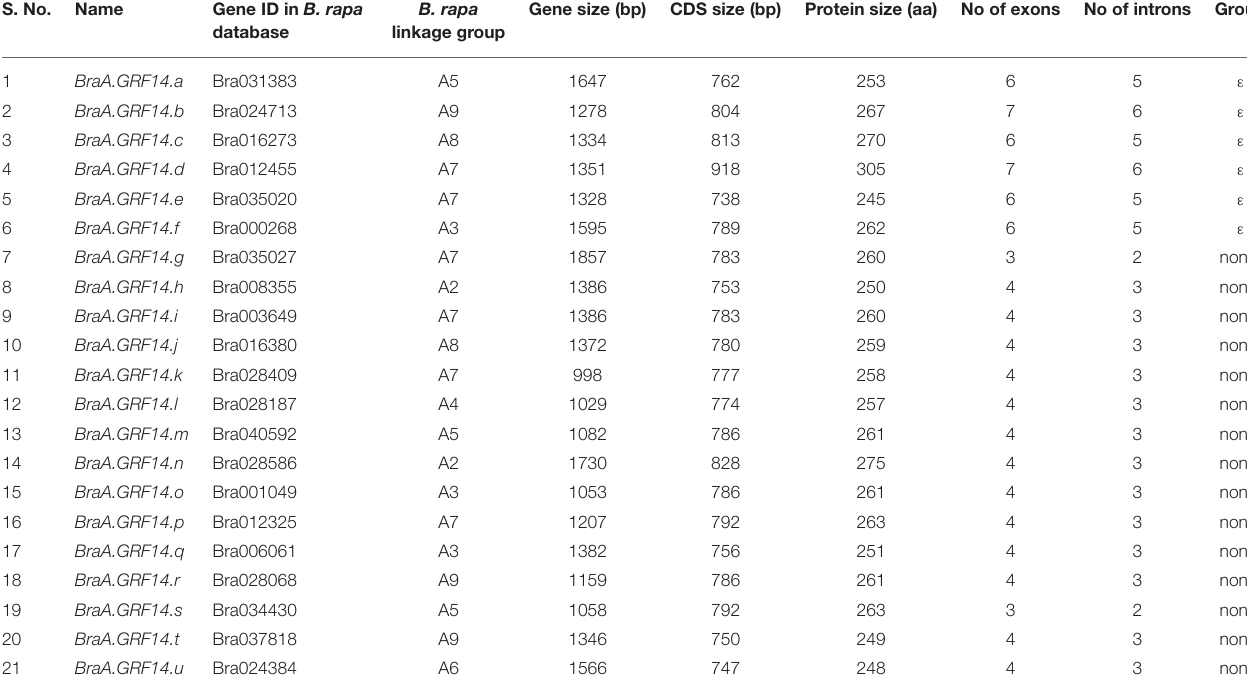
TABLE 1 | Summary of gene structure attributes of the twenty-one 14-3-3 proteins identified in B. rapa genome